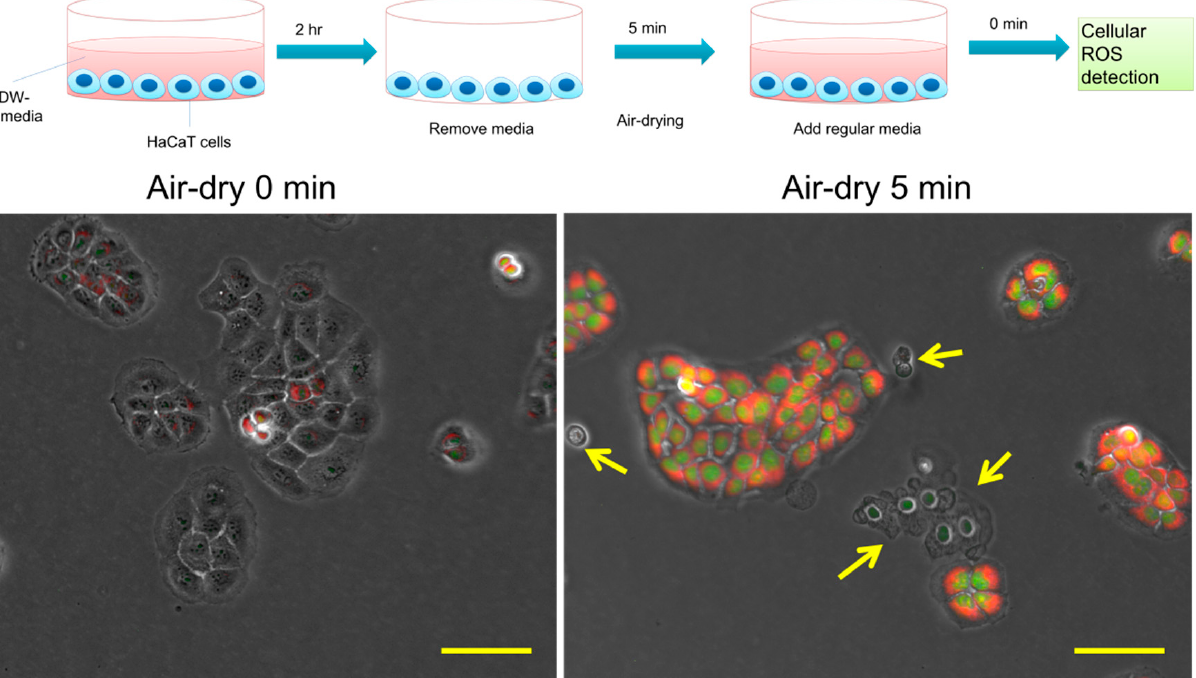
Figure 2. Dehydration causes intracellular ROS production in HaCaT keratinocytes. Cellular ROS in HaCaT cells was immediately detected after air-drying with CellROX ® Green and Orange dyes and observed with a fluorescence microscope. Illustration on the top represents procedures of the experiments. Typical fluorescence images of HaCaT cells display that, as compared to cells without air-drying (left panel), 5 min air-dried HaCaT cells produced intracellular ROS. Interestingly, some cells lost their ability to generate ROS because their damage was so serious (yellow arrows). Green, nuclei ROS; red, cytoplasm ROS. Scale bars = 50 µ